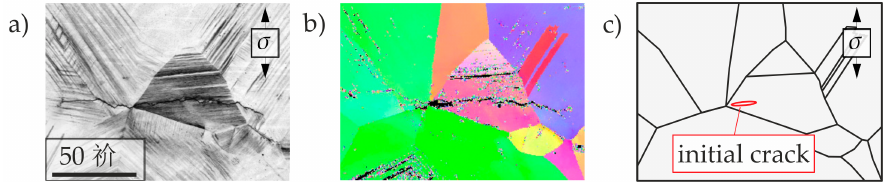
Figure 4. Scanning electron micrograph ( a ) and electron backscattered diffraction technique (EBSD) image of the polycrystalline microstructure of X2–12 ( b ) and discretization of the grain boundaries and the initial crack in the short crack growth model ( c